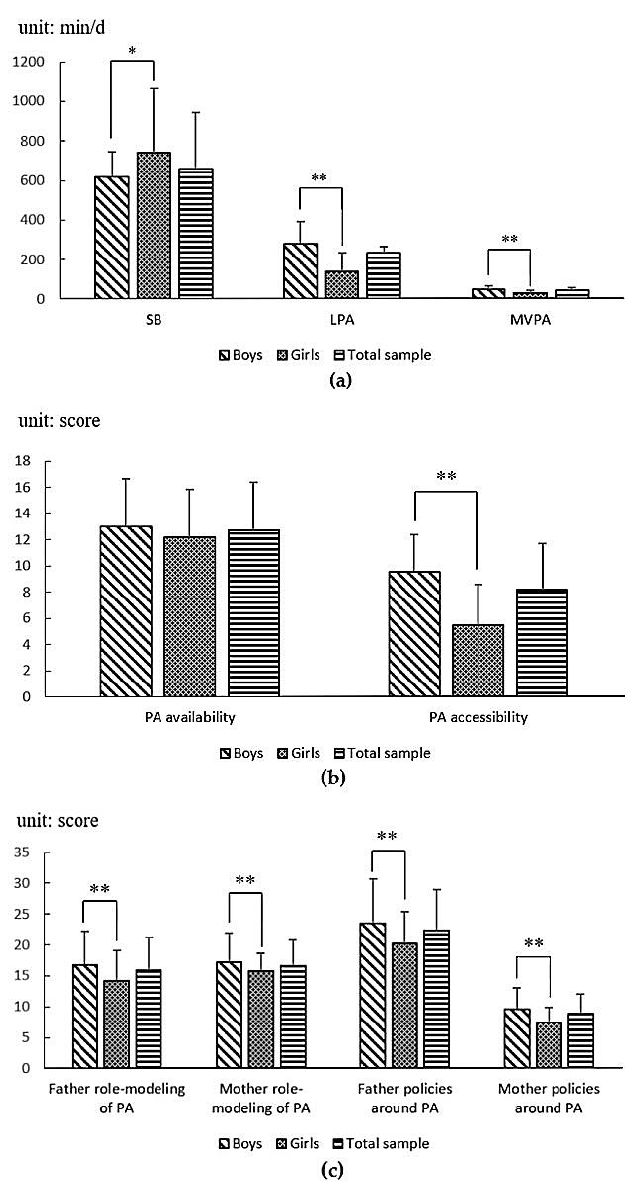
Figure 1. The gender di ff erence in ( a ) physical activity, ( b ) home-based physical environmental characteristics, and ( c ) home-based social environmental characteristics. Abbreviations: SB, sedentary behavior; LPA, light-intensity physical activity; MVPA, moderate-vigorous-intensity physical activity; PA, physical activity; min / d, minutes per day. * Significant di ff erence between boys and girls ( p < 0.05). ** Significant di ff erence between boys and girls ( p <